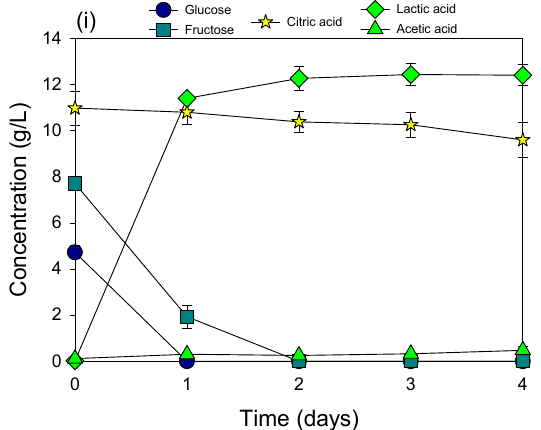
Figure 2. Fermentation of cucumber extract neutralized by NaOH using Lactobacillus plantarum ( a ), Pediococcus acidilactici ( b ), Lactobacillus acidophilus KCTC 3164 ( c ), Lactobacillus delbrueckii subsp. lactis KCTC 3636 ( d ), Lactococcus lactis subsp. lactis KCTC 2013 ( e ), Lactobacillus salivarius subsp. salicinius KCTC 3600 ( f ), Lactobacillus helveticus KCTC 3545 ( g ), Lactobacillus casei KCTC 13086 ( h ), and Lactobacillus paracasei KCTC 13169 ( i ).